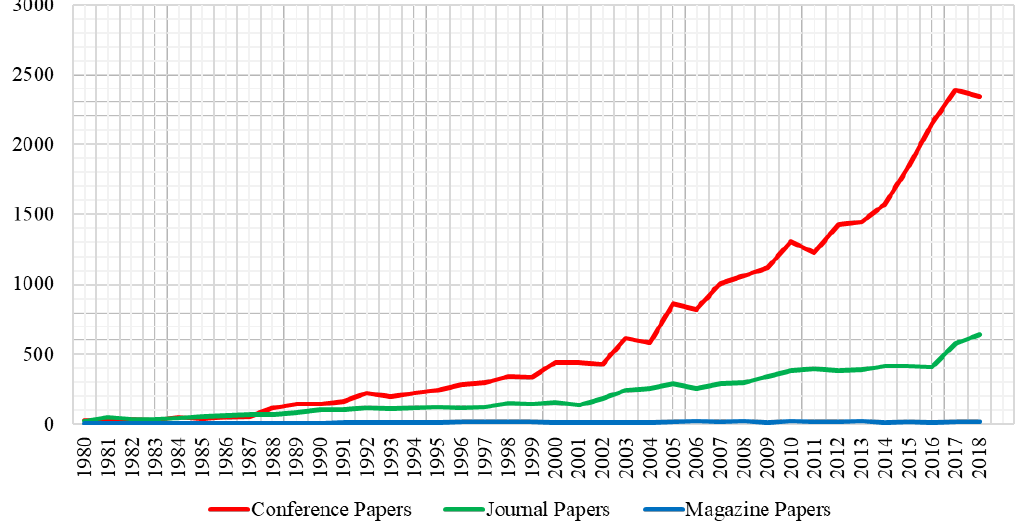
Figure 1. Number of patch antenna papers indexed in IEEE Xplore® Digital Library between